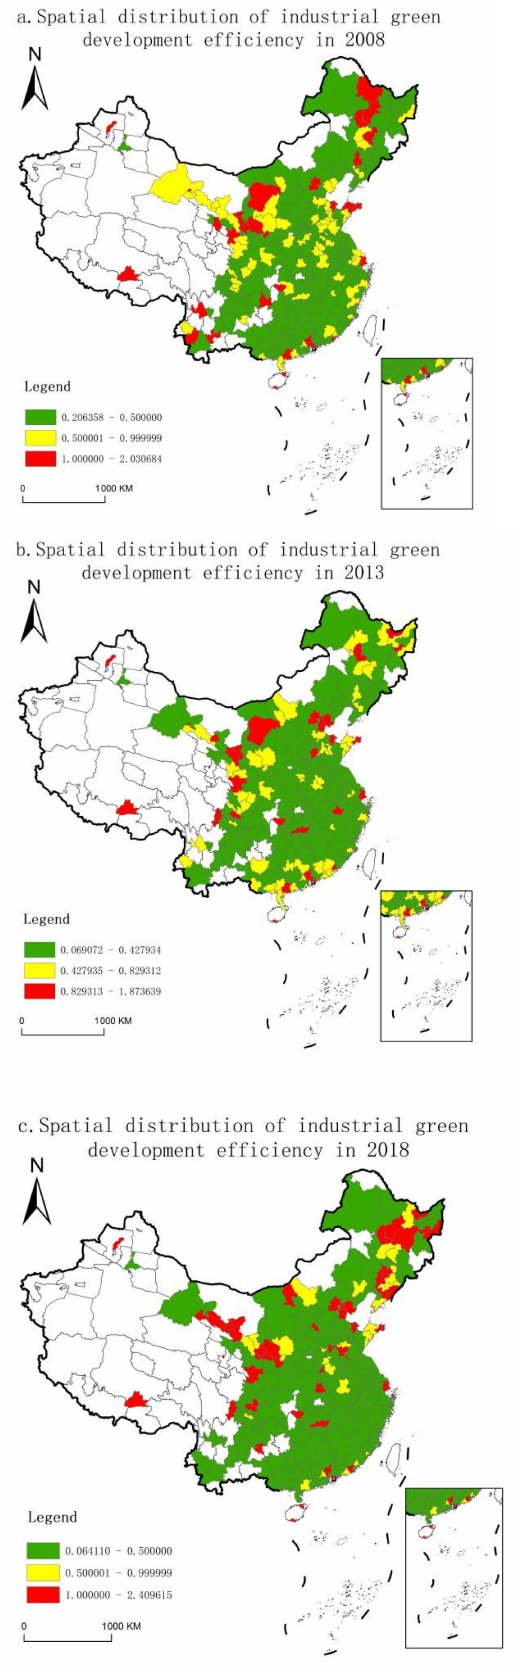
Figure 3. Spatial distribution of IGDE in 2008, 2013, and